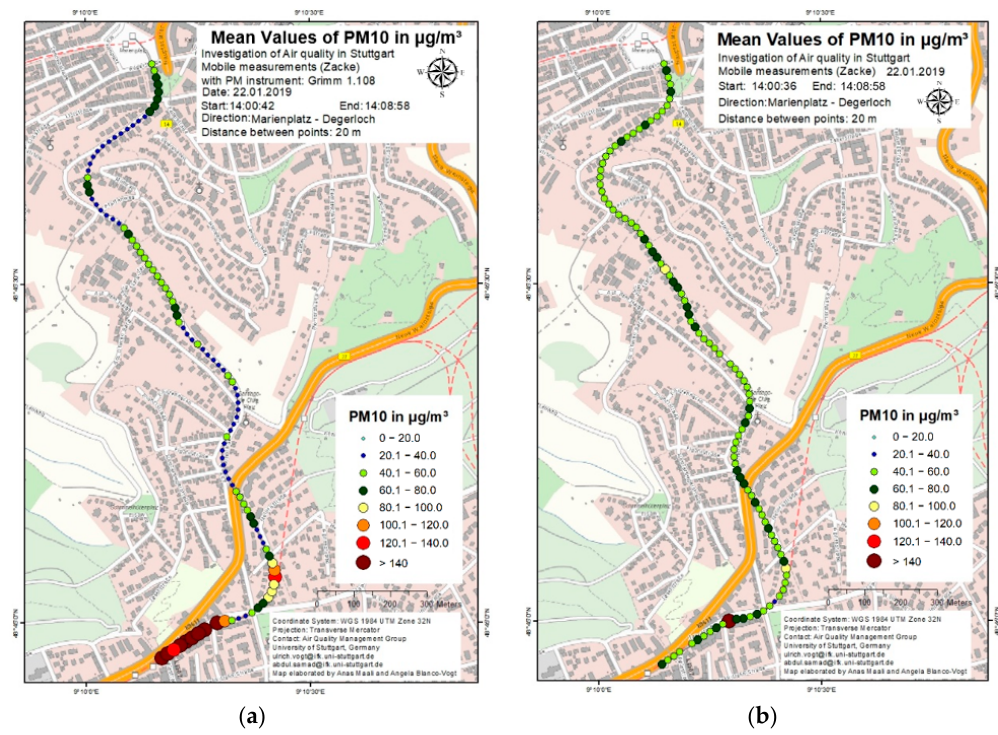
Atmosphere 2021 , 12 , x FOR PEER REVIEW Figure 12. PM10 concentration using ( a ) mobile aerosol spectrometer ( b ) sensor-monitoring box.